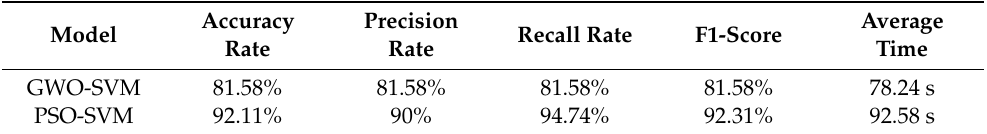
Table 6. Comparison of different optimization methods.